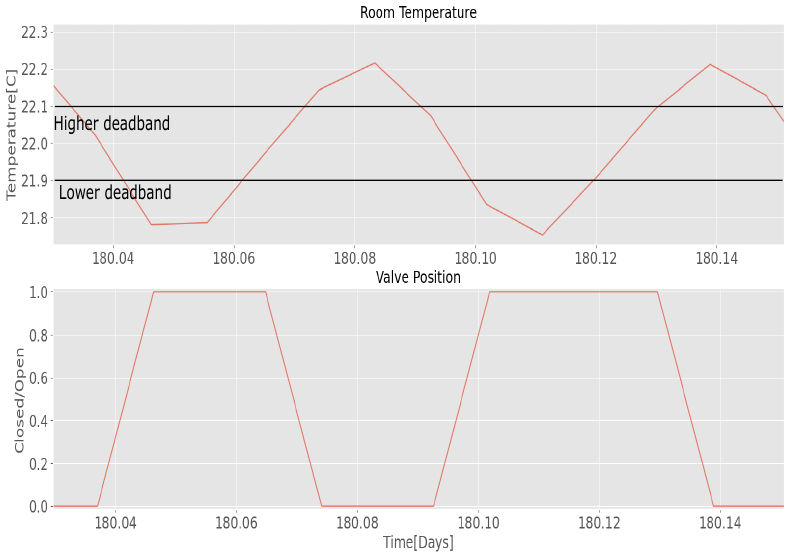
Figure 3. Room temperature and associated valve position over a period of 8640 s (0.1 days). By investigating the graph, the dynamic response can be analyzed.